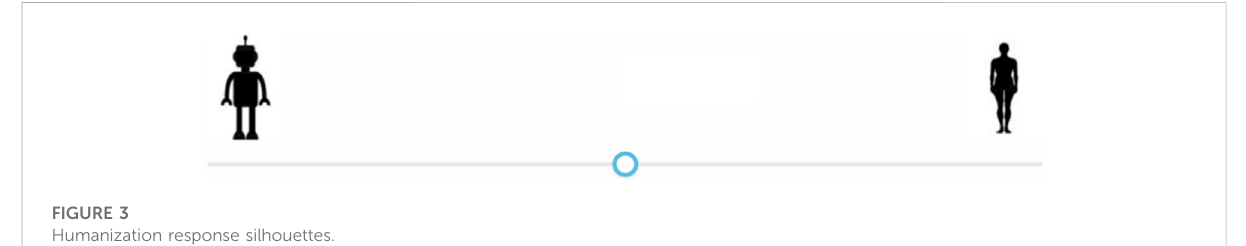
FIGURE 3 Humanization response